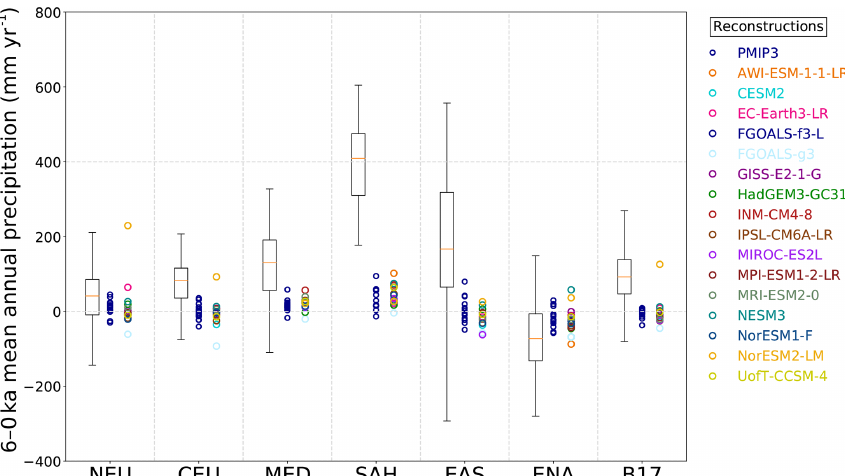
Figure 8. Comparison between simulated annual precipitation changes and pollen-based reconstructions (from Bartlein et al., 2011). Seven regions where multiple quantitative reconstructions exist are chosen. Six of them are defined following Christensen et al. (2013) and are northern Europe (NEU), central Europe (CEU), the Mediterranean (MED), the Sahara/Sahel (SAH), East Asia (EAS) and eastern North America (ENA). Mid-continental Eurasia (B17) is specified by Bartlein et al. (2017) as 40–60 ◦ N, 30–120 ◦ E. The distribution of recon- structions within the region are shown by boxes and whiskers. The area-averaged change in mean annual precipitation simulated by CMIP6 (individually identifiable) and CMIP5 (blue) within each region is shown for comparison (following Flato et al.,